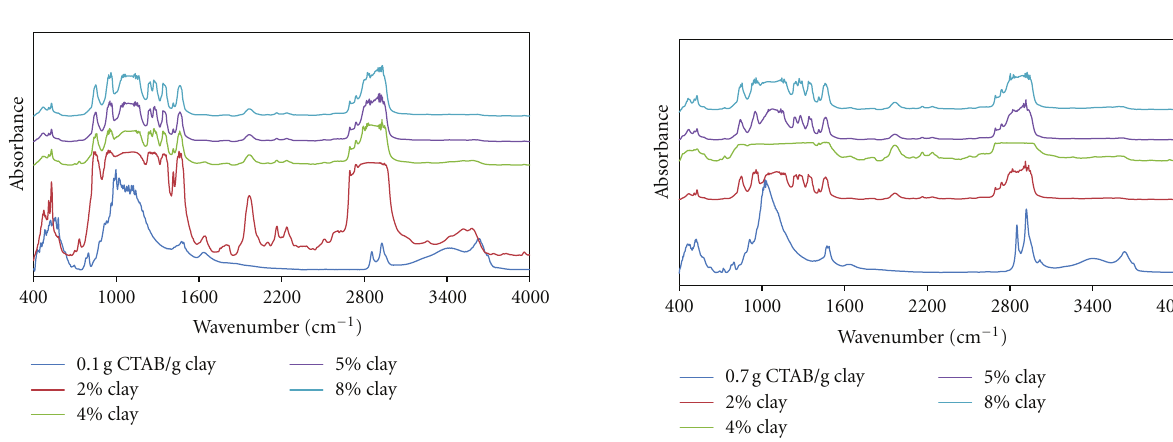
Figure 10: FTIR spectra of produced PEO/clay nanocomposites at various clay compositions (0.7 g CTAB/g clay